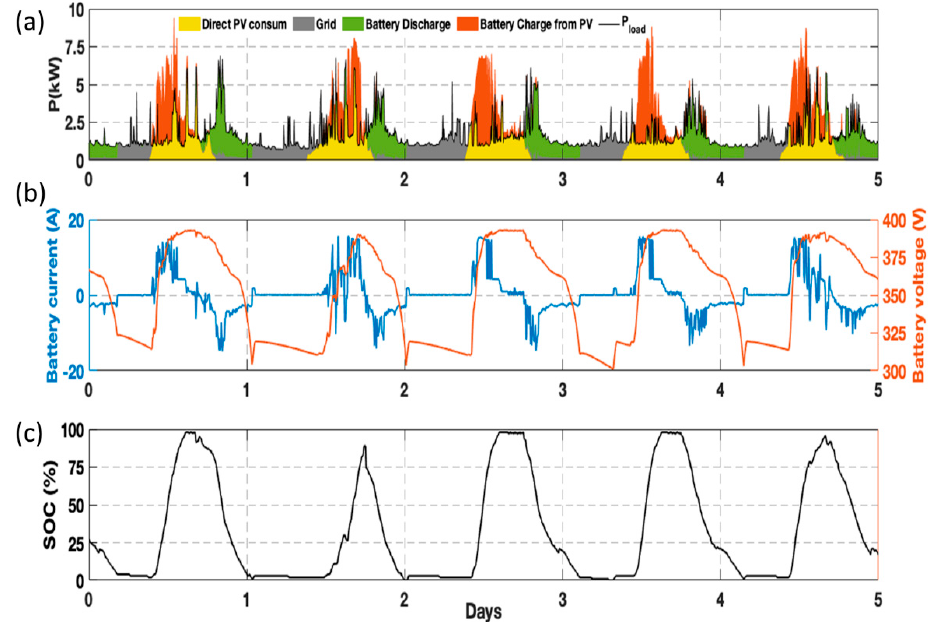
Table 3. Main parameters of the microgrid for different scenarios.